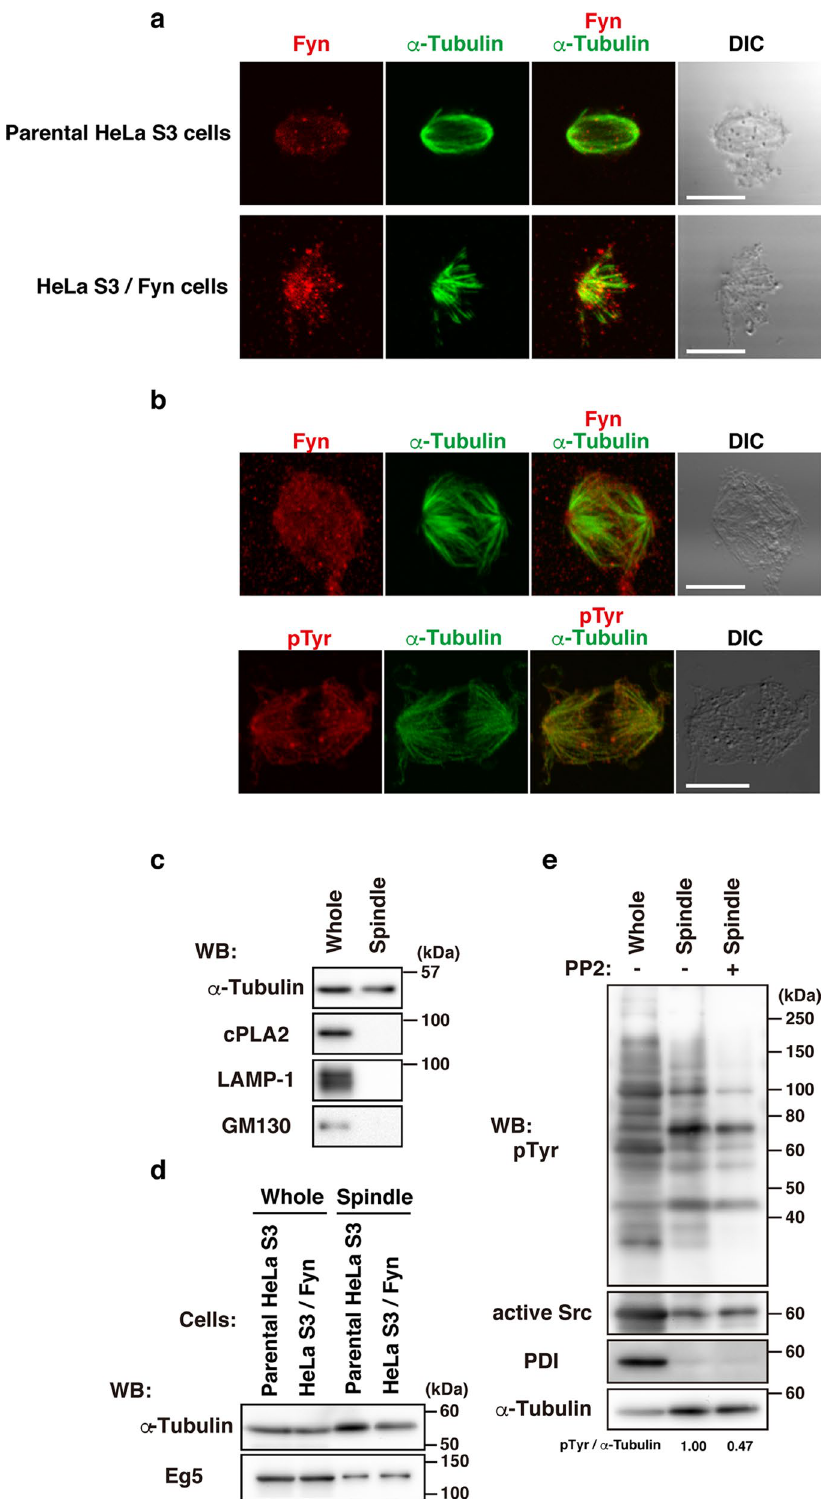
Figure 2. Tyrosine phosphorylation on mitotic spindles. Taxol-stabilized mitotic spindles were isolated from cells released from nocodazole-induced arrest (see “Methods”). (a) Mitotic spindles isolated from parental HeLa cells (upper panels) and HeLa S3/ Fyn cells (lower panels) were doubly stained for endogenous Fyn (red) plus α-tubulin (green) (upper panels) and expressed Fyn (red) plus α-tubulin (green) (lower panels). Scale bar, 10 μm. (b) Mitotic spindles isolated from HeLa S3/Fyn cells were doubly stained for Fyn (red) plus α-tubulin (green) (upper panels) and pTyr (red) plus α-tubulin (green) (lower panels). Scale bars, 10 μm. (c–e) Mitotic spindles isolated from (c) HeLa S3/Fyn cells, (d) parental HeLa S3 and HeLa S3/Fyn cells, and (e) HeLa S3/ Fyn cells treated with or without 10 µM PP2 were lysed and analyzed by Western blotting using the indicated antibodies. Cellular tyrosine phosphorylation levels are shown relative to that in each control sample following normalization with α-tubulin